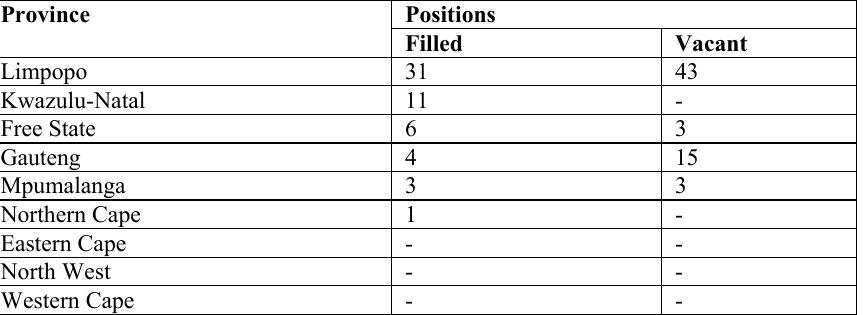
A summary of optometrist posts in the public sector in the nine Provinces of South Africa. The Limpopo Province has the highest number of posts. Eastern Cape, North West and Western Cape Provinces are yet to create positions for